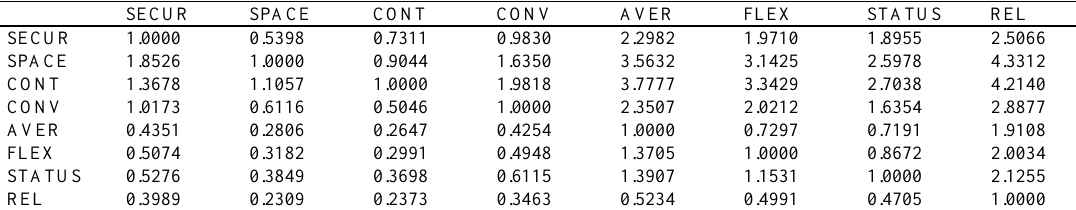
Table 3. Aggregated pair-wise comparison